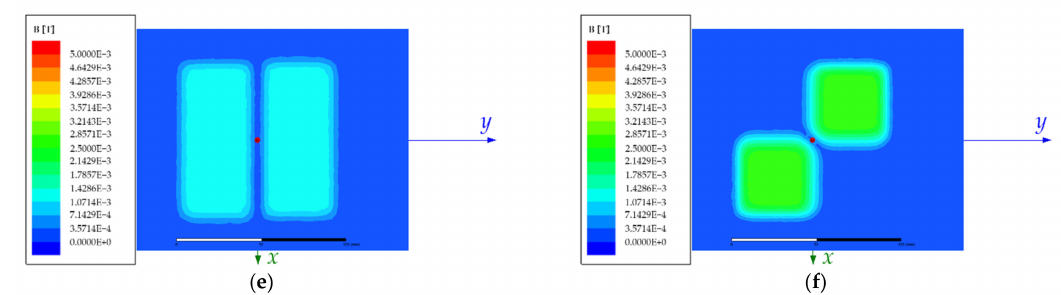
Figure 13. Simulated magnetic flux density of the single and double DD coil structures: ( a ) magnetic flux density of the single DD in the x - z plane; ( b ) magnetic flux density of the single DD in the y - z plane; ( c ) magnetic flux density of the double DD in the x - z plane; ( d ) magnetic flux density of the double DD in the y - z plane; ( e ) magnetic flux density of the single DD in the x - y plane; ( f ) magnetic flux density of the double DD in the x - y